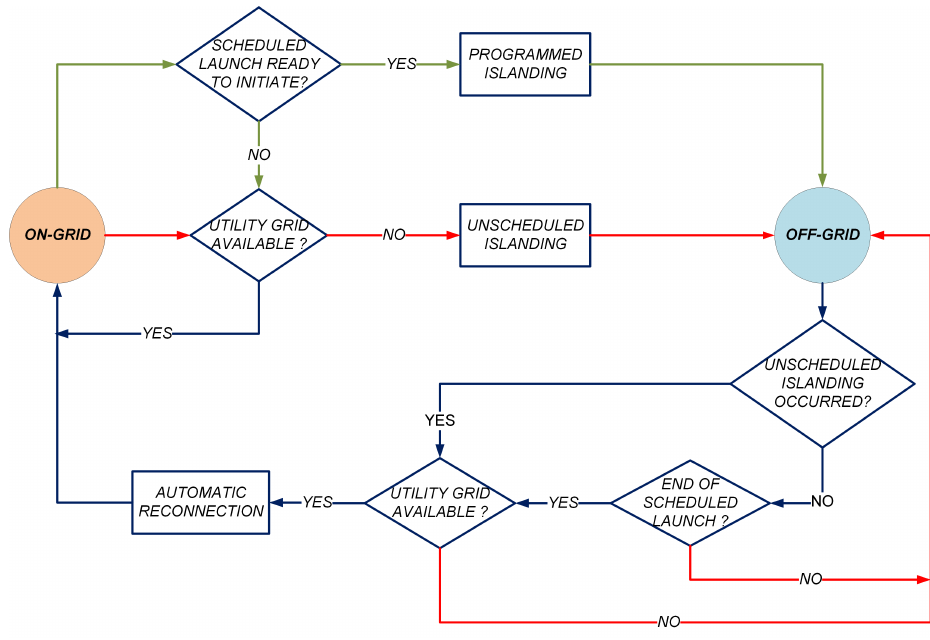
Figure 3. ASC- µ Grid transition